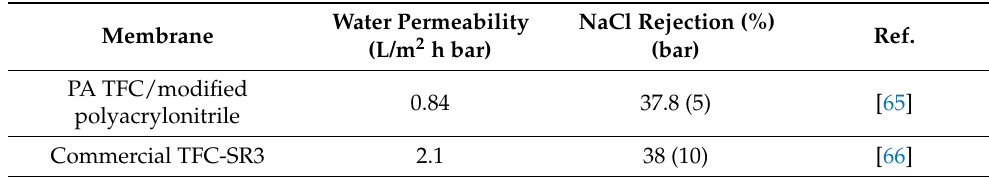
Table 4. The performance comparison of PA TFC membranes reported in the literature with the ones established in this